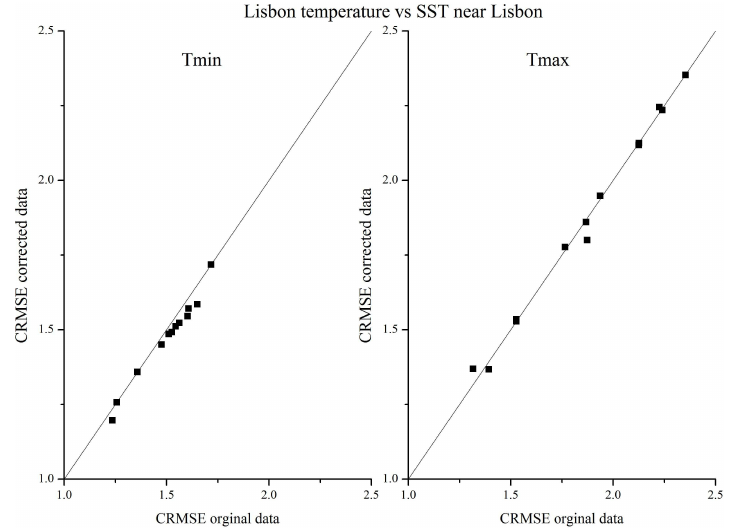
Figure 18. Lisbon: scatter plots of CRMSE before and after homogenization of 12 monthly and the annual series for T min (left) and T max (right). SST Lisbon anomalies data are used as reference series. Dots on or below the bisect indicate data sets with unchanged or improved (increased) homogeneity, while dots above the bisect indicate data sets with increased